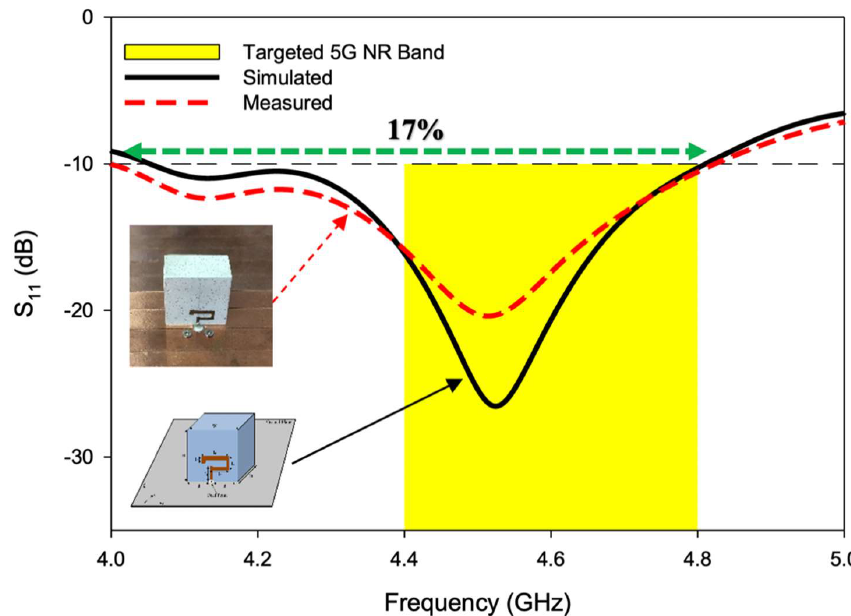
Figure 12. Simulated and measured S11 of the CP 5G RDRA.